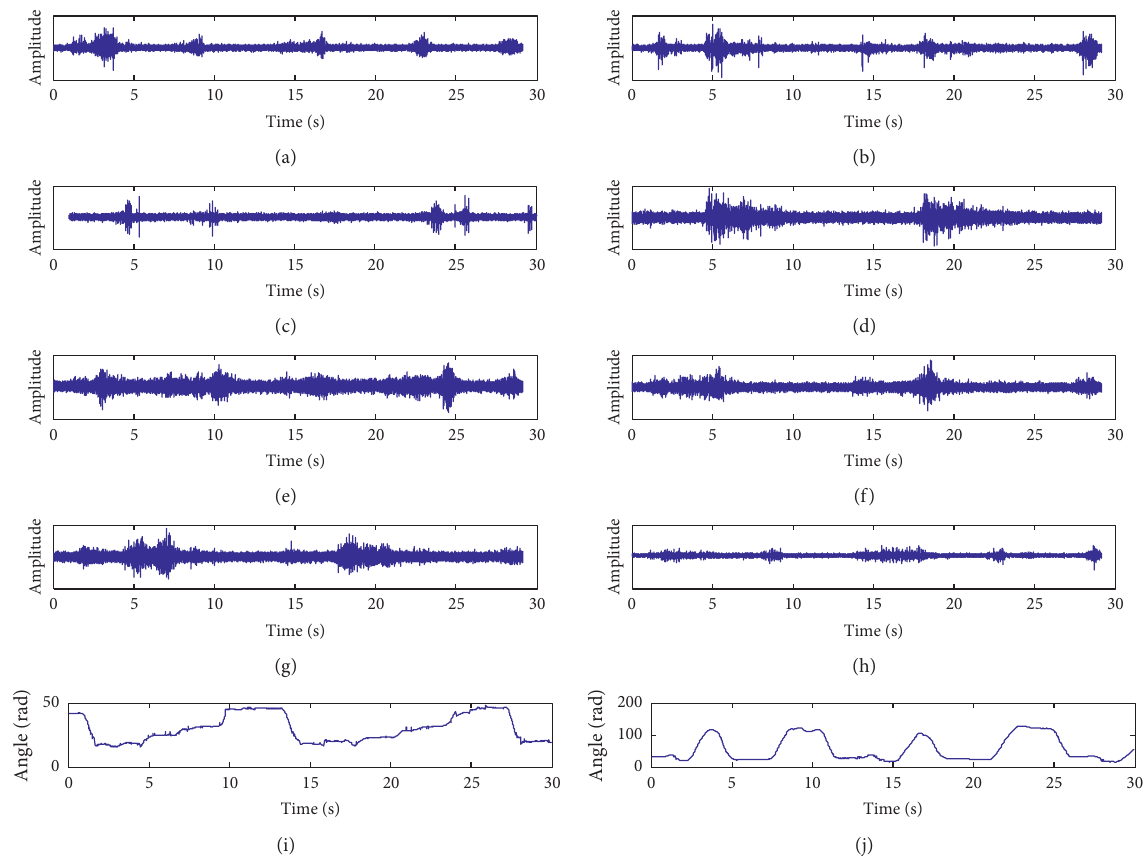
Figure 7: (a–h) MMG signals from BB, TB, BR, TZ, TM, AD, LD, and PM. (i) Angle signal of shoulder joint. (j) Angle signal of elbow joint